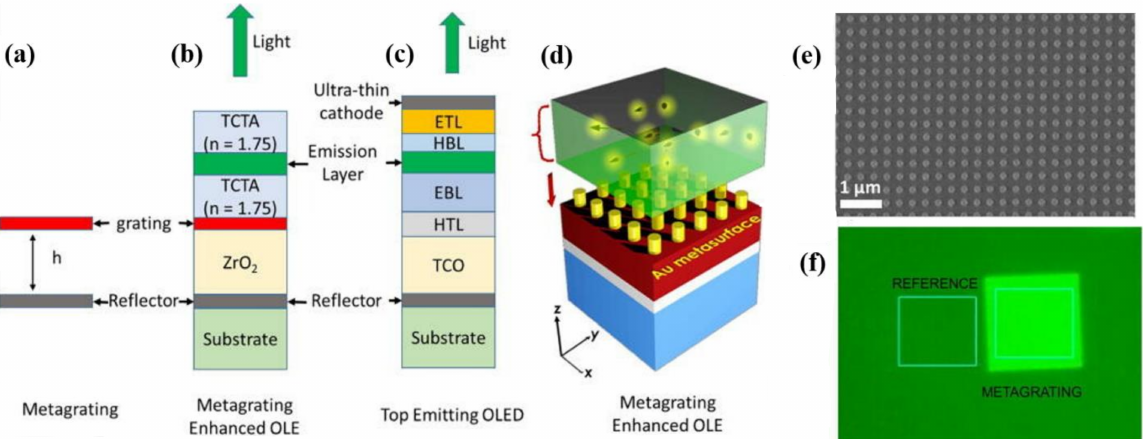
Figure 13. Metagrating enhanced organic light emitting diode structure. ( a – c ) Schematic layer structure of a 2D metagrating placed above a metal reflector with its implementation in a light emitting device and its ( d ) 3D rendering schematics. ( e ) SEM image of metagrating consisting of Au cylinders and ( f ) bright emission image (filtered at λ = 520 nm) demonstrating the light enhancement in case of a metagrating integrated device. Reproduced from [141], © (2020) AIP